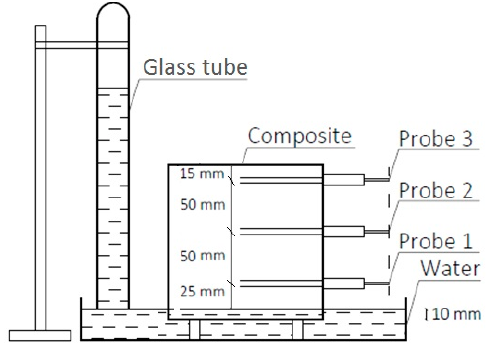
Figure 3. Schematic view of the measuring setup.